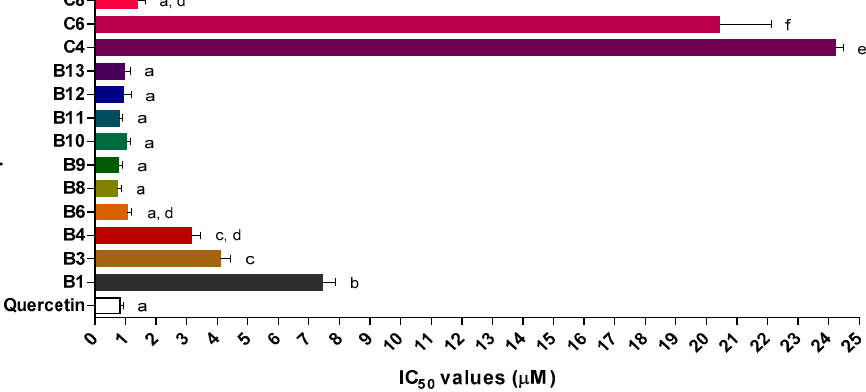
Figure 6. Graphical representation of IC 50 values of active 2-SC and the positive control, quercetin ( µ M, mean ± SEM, n ≥ 3). Same letters indicate that IC 50 values are not statistically different and different letters indicate that IC 50 values are statistically different from each other ( p < 0.05).